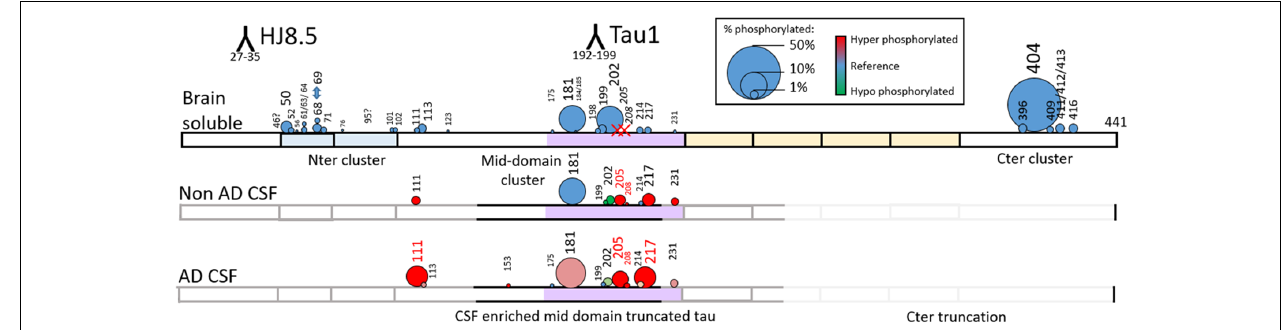
FIGURE 11 | Relative abundance of tau phosphorylation depends on the biological extract and varies across the protein sequence. Comparison of tau phosphorylation abundance measured by MS in normal brain lysate, normal CSF and AD CSF extracted by immunocapture using HJ8.5 and Tau1. Circle area is proportional to site phosphorylation abundance. Red and green colors indicate an increase or decrease, respectively, in comparison to the brain soluble profile taken as reference (blue). Tau is c-terminally truncated in CSF, which explains the absence of detection of the C-terminal cluster of phosphorylation sites. Phosphorylation on T205 and S208 is specific to CSF (red X on Brain Soluble—top).